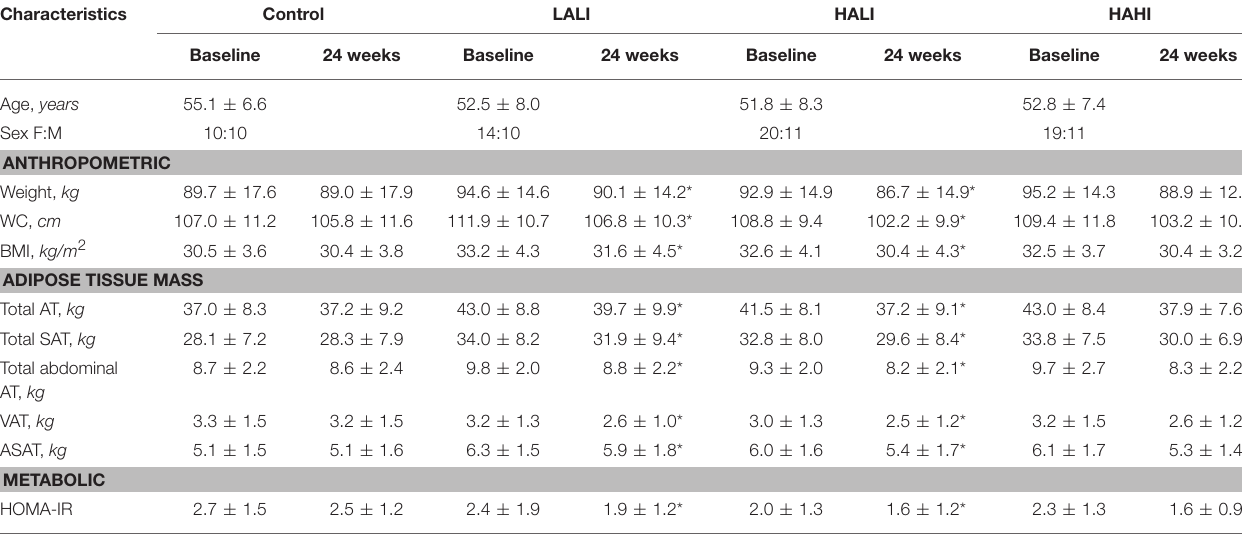
TABLE 1 | Participant characteristics at baseline and 24 weeks.